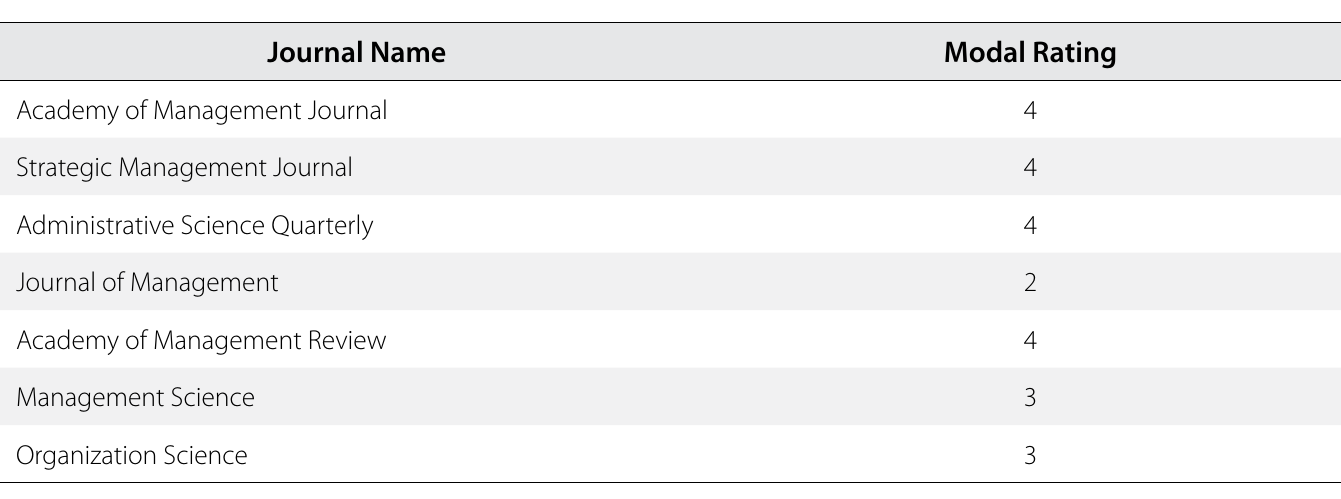
Table 4. Mean Quality (Modal) Rating of Journals (MacMillan,